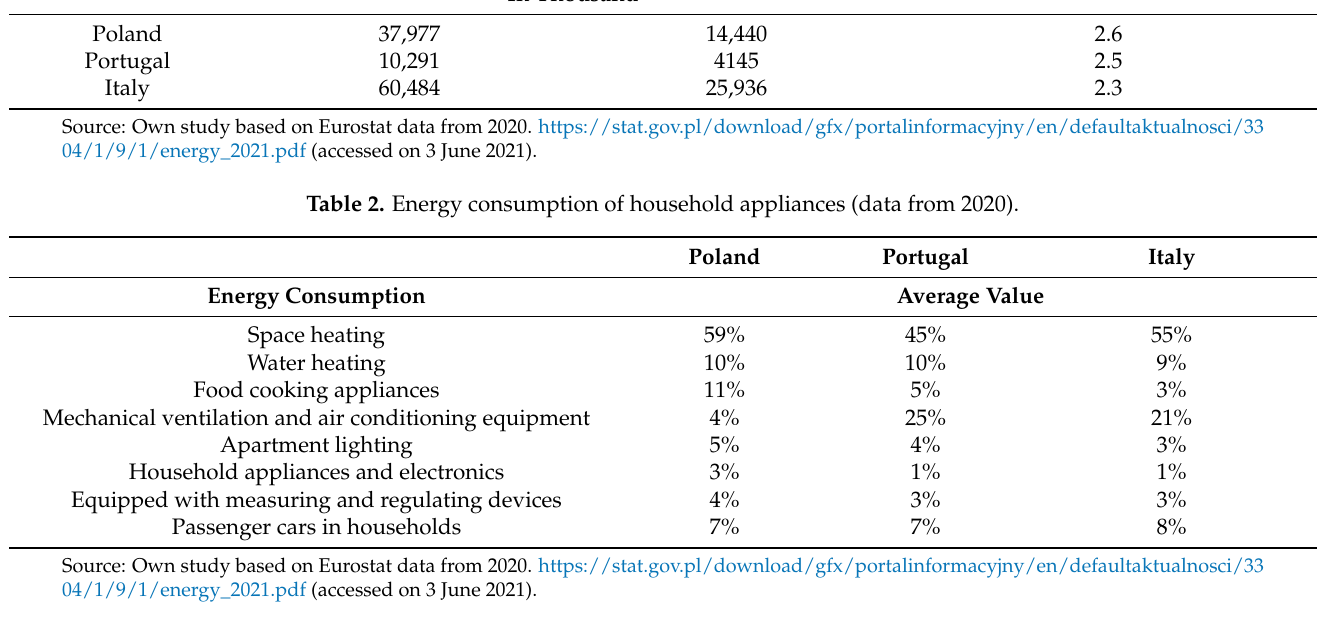
Table 3. Household expenditure on energy carriers in